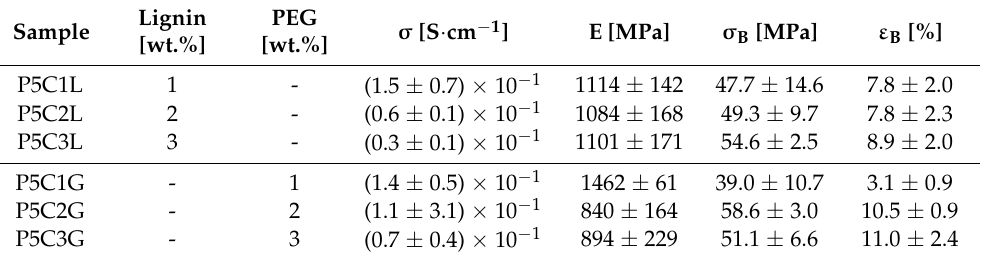
Table 4. Lignin and PEG percentages in samples with common PLA/MWCNT (95/5 wt.%), electrical conductivity, and mechanical